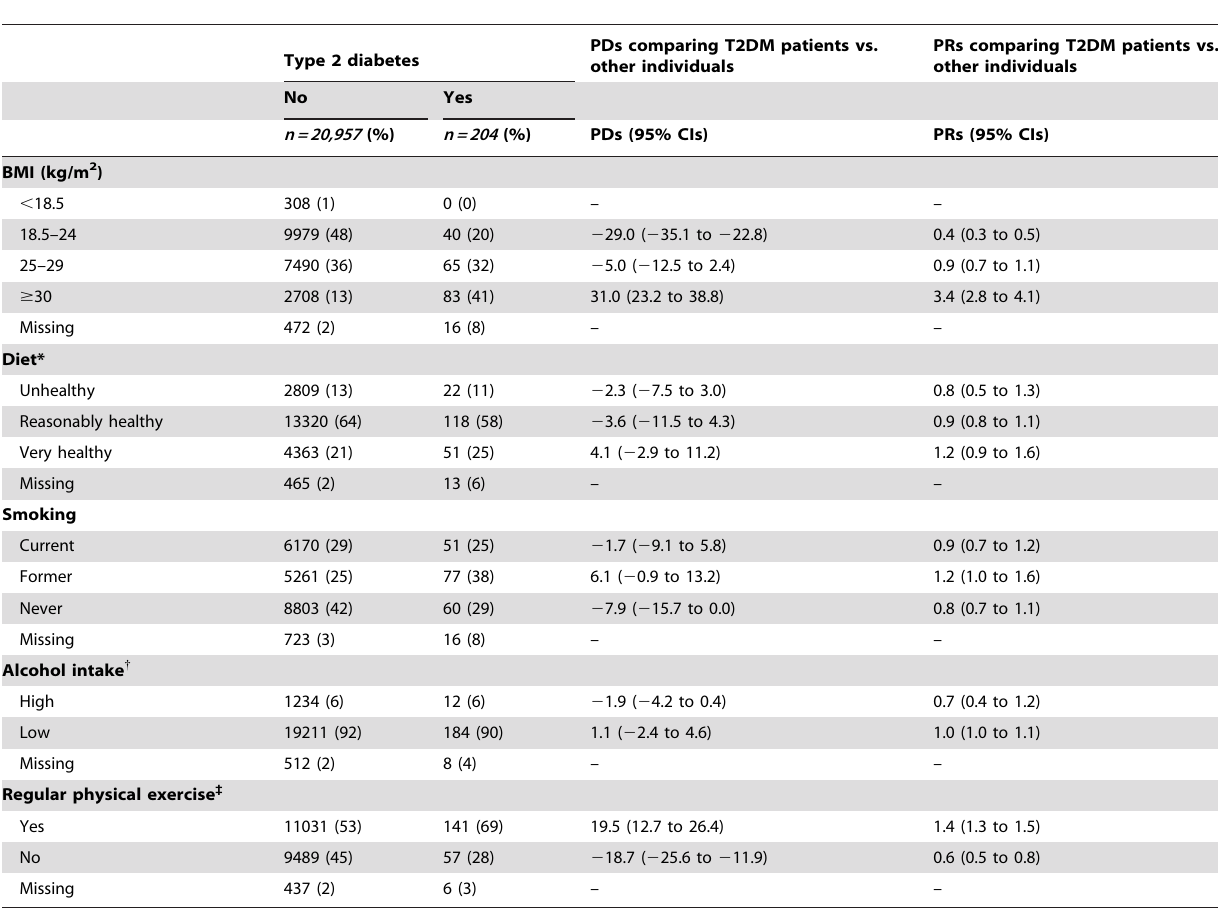
Table 3. Age-and gender-standardized prevalence differences (PDs) and prevalence ratios (PRs) of lifestyle factors among newly diagnosed # type 2 diabetes